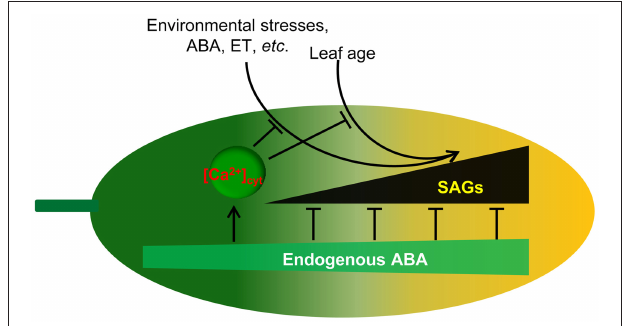
FIGURE 9 | Proposed model for endogenous ABA function in leaf senescence. Leaf age or environmental stresses trigger the onset of senescence through the promotion of SAG expression. Endogenous ABA not only promotes plant growth and development but also inhibits leaf senescence onset through the inhibition of SAG expression. Meanwhile, endogenous ABA content increases with environmental stresses and leaf age. [Ca 2 + ] cyt is involved in the regulation of this process. Thus, ABA appears to act as a key regulator linking internal and external factors and leaf senescence.